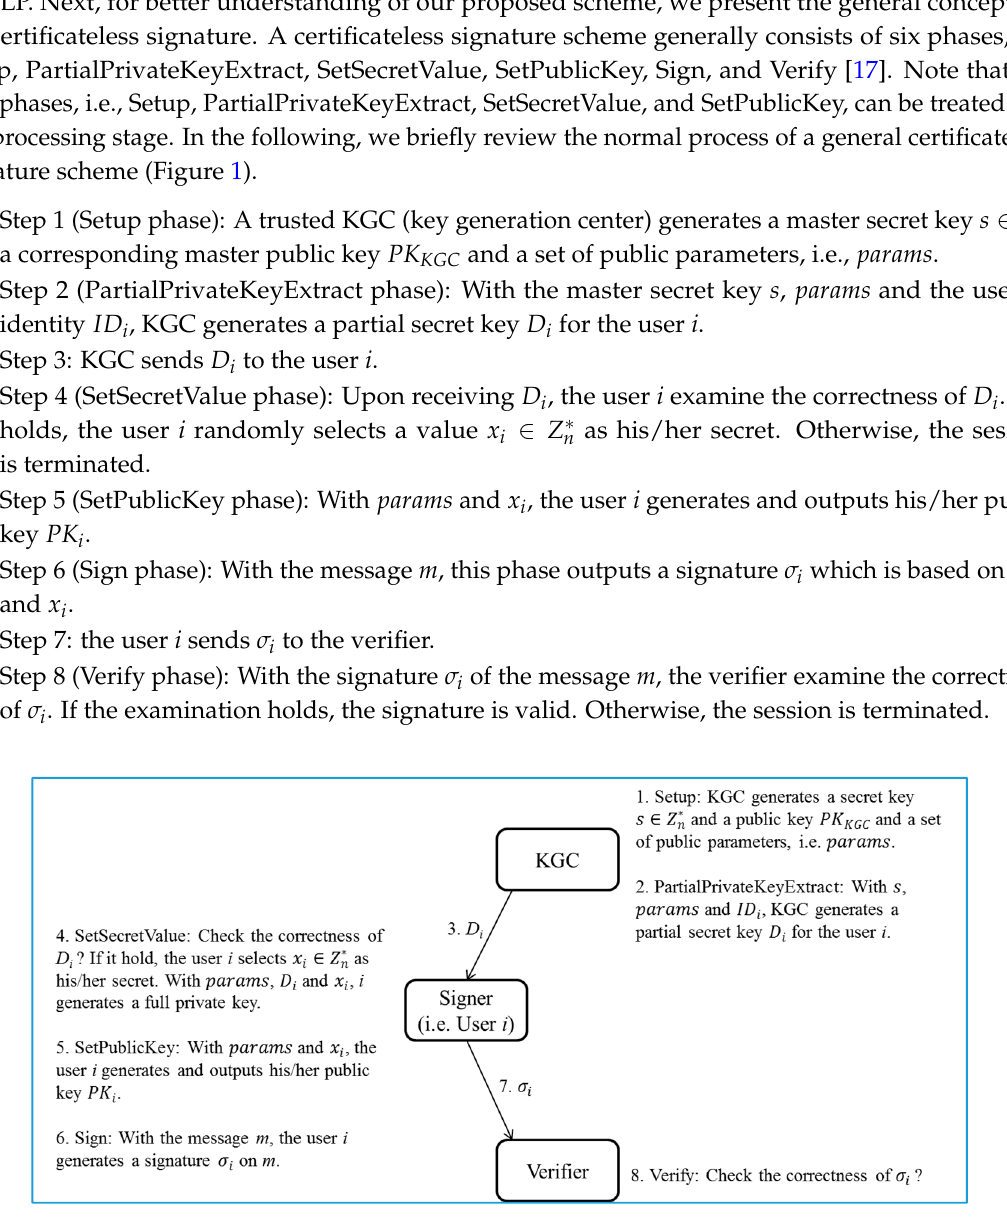
Figure 1. The normal process of a general certificateless signature scheme.